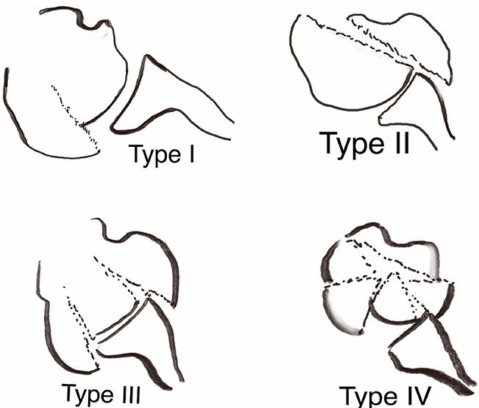
Figure 2. Four different types of head-split fracture patterns depending on involvement of the head-split component adjacent tuberosity ( Type I : greater tuberosity; Type II : lesser tuberosity), whether fracture fragments split into disconnecting pieces that may lead to a stamp-like frac- ture pattern resulting in both greater and lesser tuberosity fragments connected to the articular face ( Type III ) or the multifragmentation of the disconnection of split pieces ( Type IV ) [7]. (Re- produced, with modification, under Creative Commons Attribution 4.0 International.